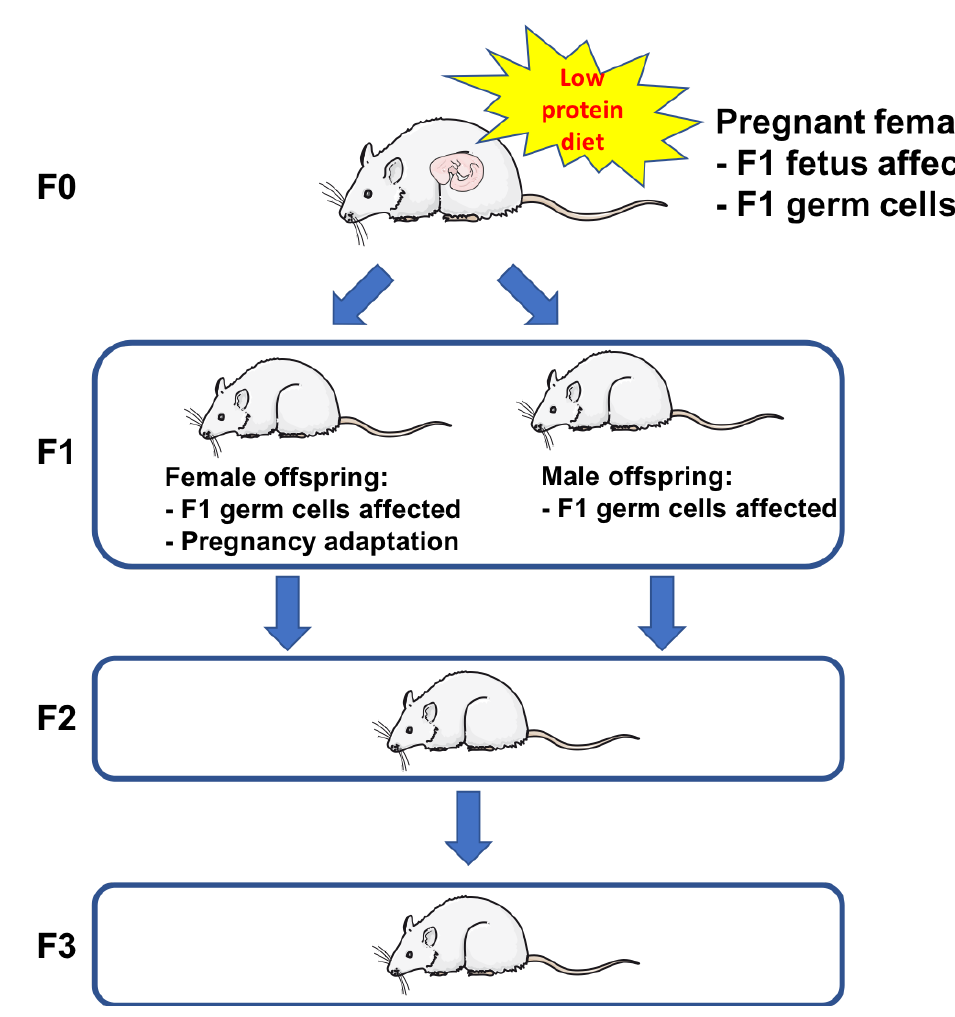
Figure 2. Transgenerational programming. Adapted from Briffa JF, Wlodek ME, Moritz KM. Transgenerational programming of nephron deficits and hypertension. Seminars in Cell and Developmental Biology . 2018, Jun 7.